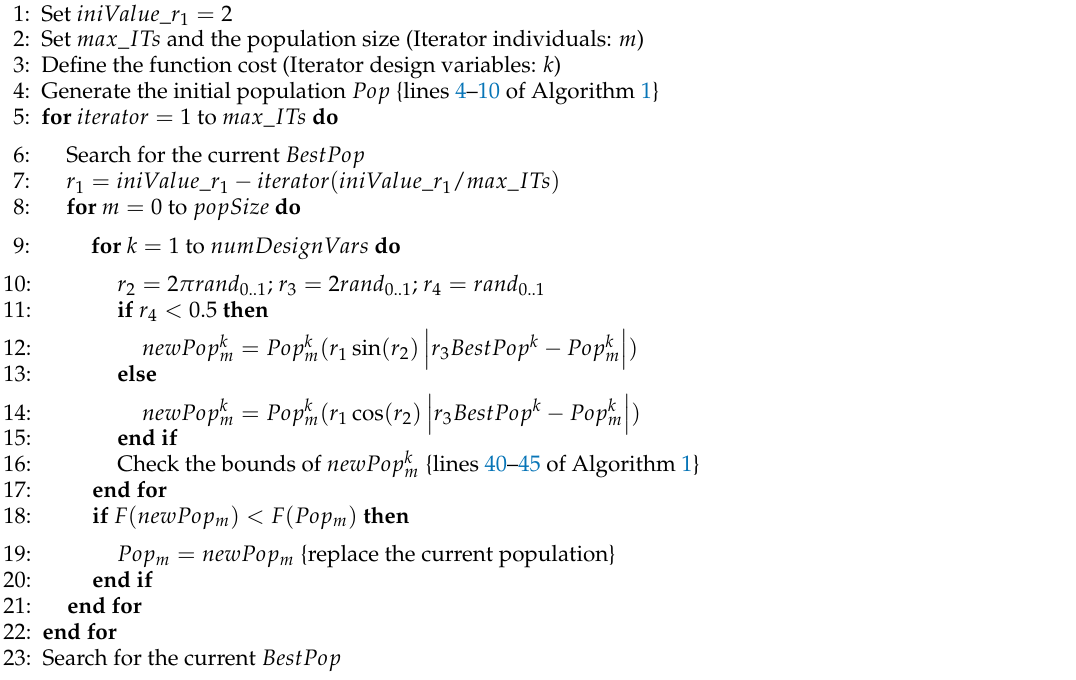
Algorithm 2 SCA optimization